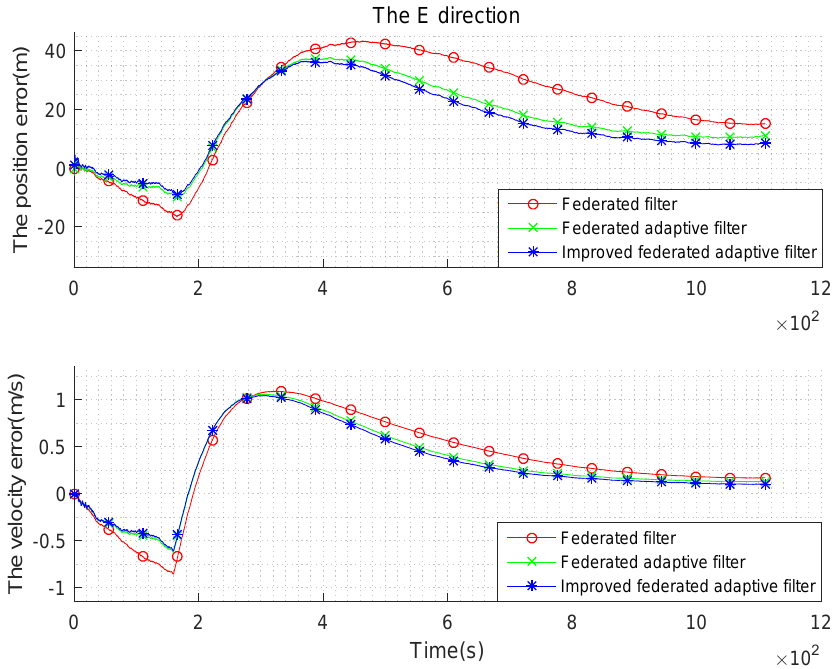
Figure 7. Comparison of the navigation error with Gaussian state noise and biased estimation in E direction.